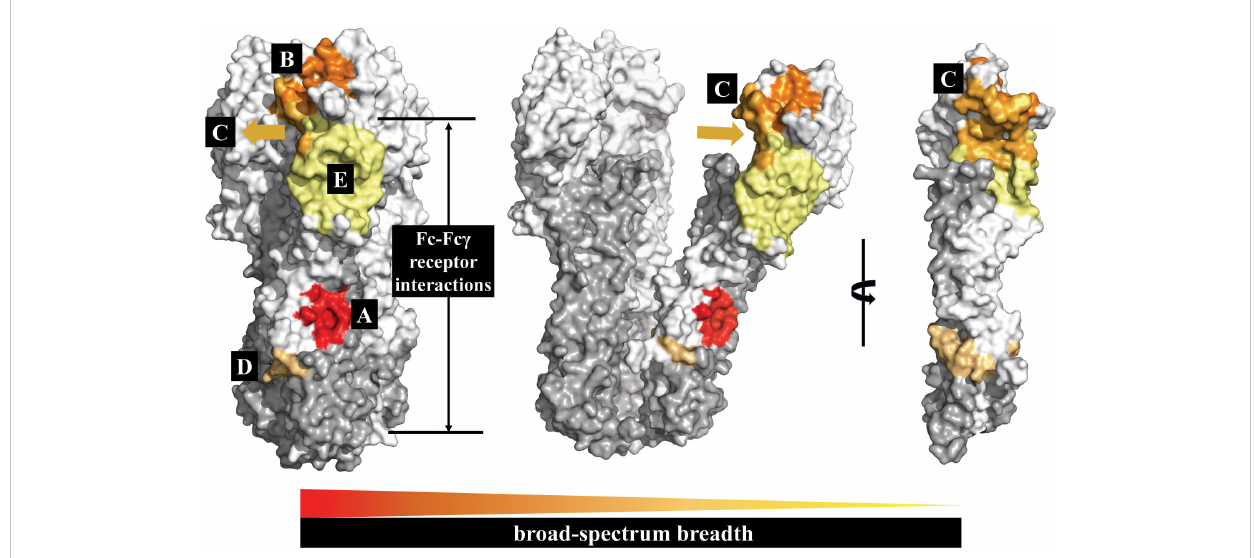
FIGURE 4 The HA conserved epitope regions of in fl uenza A virus. HA1 is shown in white, HA2 in gray. The fi ve conserved protective epitope regions summarized in this review: (A) The hydrophobic groove region is shown in red; (B) the RBS in orange; (C) the occluded epitope region of the HA monomers interface in light orange; (D) the fusion peptide region in orange-yellow; and (E) the VE subdomain in yellow. The broad-spectrum breadth of the fi ve conserved protective epitope regions are ranked